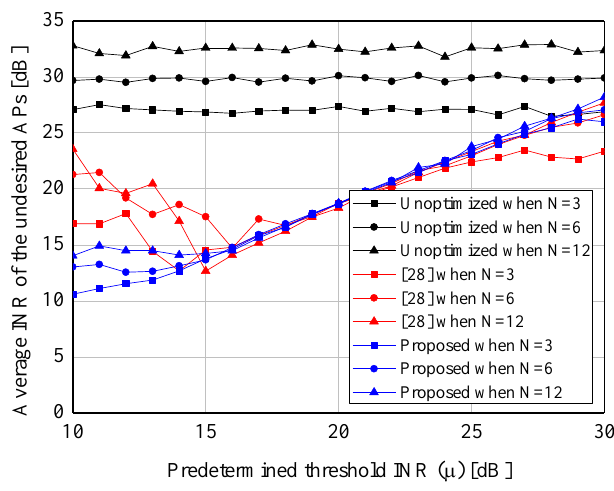
(cid:0) (cid:1) ϑ opt , Γ 1 .